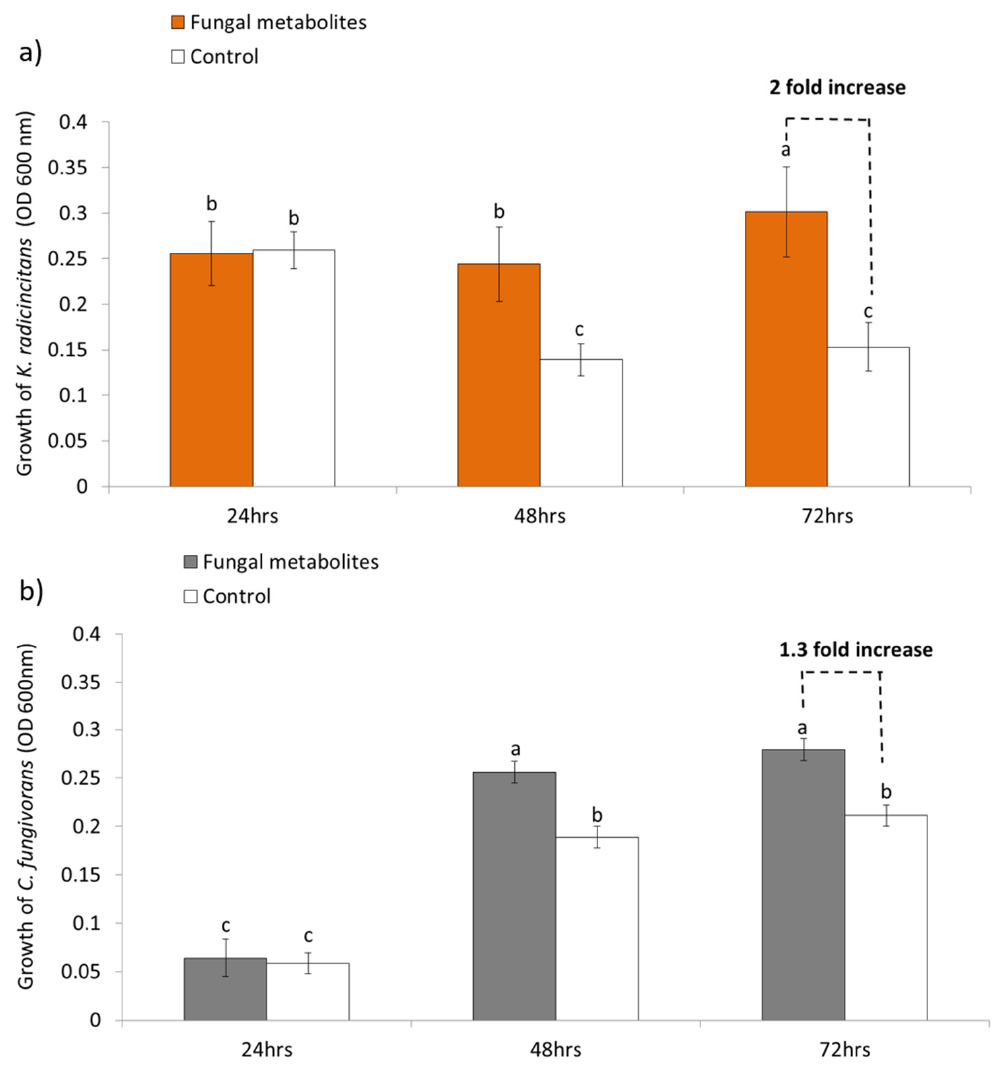
Figure 3. Growth of ( a ) K. radicincitans and ( b ) C. fungivorans when cultivated in M9 medium amended with metabolites extracted from complete medium (CM) inoculated with S. indica after two weeks of incubation. White bars represent the growth of K. radicincitans and C. fungivorans in the control treatments amended with metabolites extracted from CM medium without S. indica . OD 600 nm was measured in all the treatments after 24 h, 48 h, and 72 h. Different letters above bars represent significant differences ( p < 0.05) according to two-way ANOVA using treatment ( S. indica metabolites or CM without fungus) and time (2 h and 72 h) as factors; followed by a Tukey’s additive test. Error bars indicate the standard deviation of means of twelve different replicates.